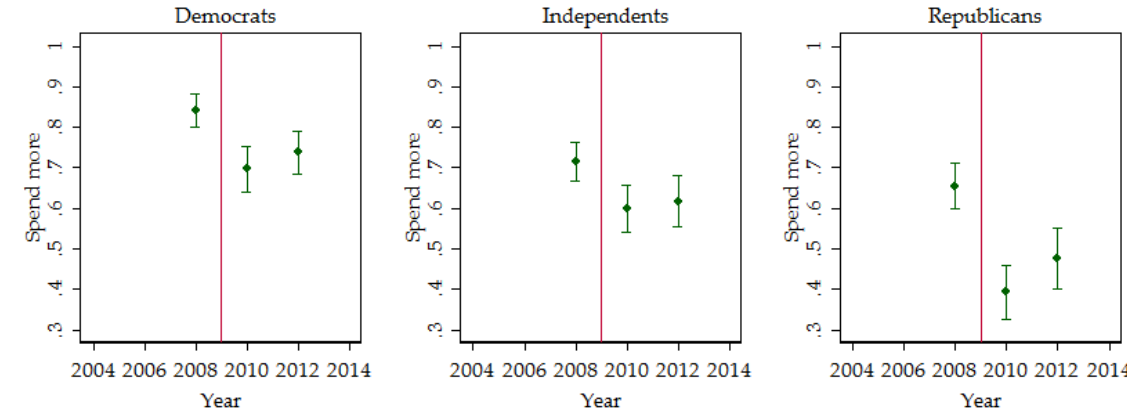
Figure 5: Proportion of respondents, by party identification, who indicate that “too little” money is spent on the nation’s health, for the 2008 Cross-sectional Sample, Re-interviewed in 2010 and